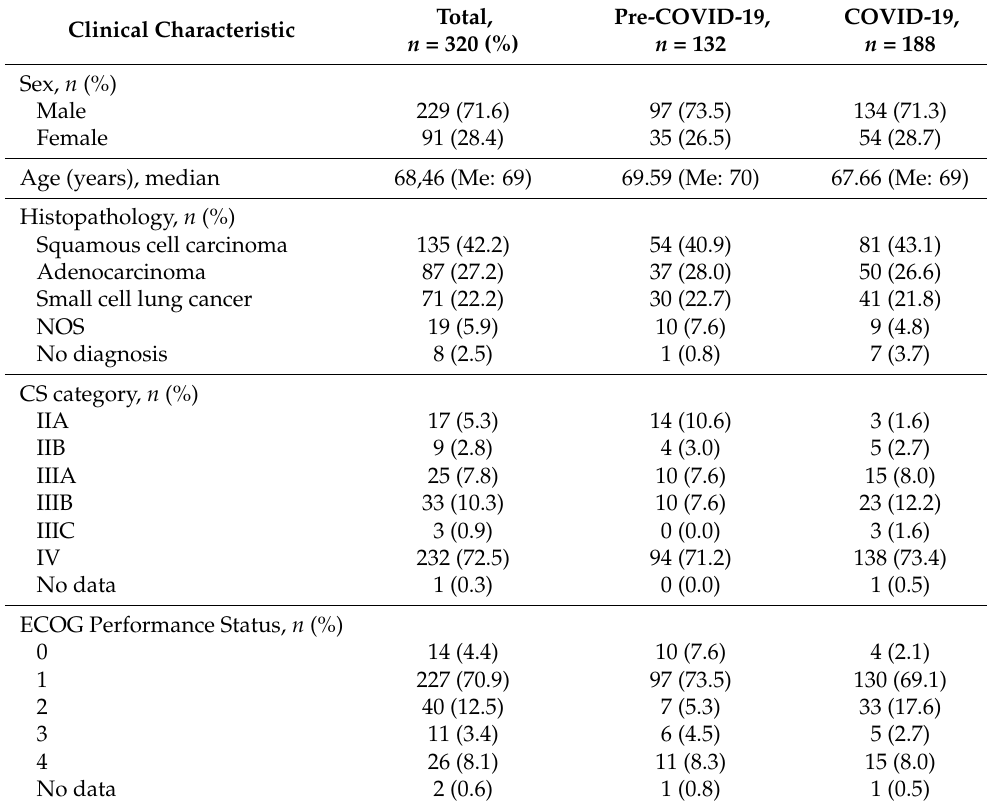
Table 3. The clinical characteristics of patients included in the analysis.